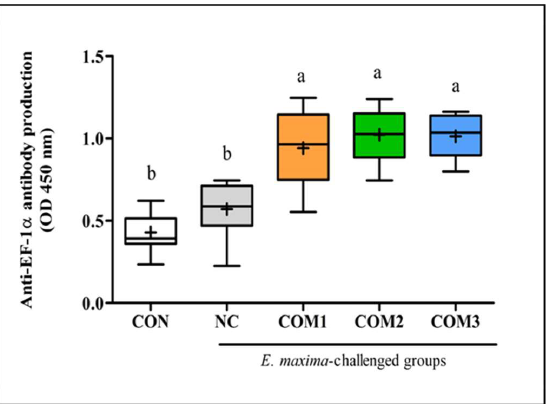
Figure 2. Synergetic effect of recombinant EF-1α and B. subtilis expressing cNK-2 peptide on anti- EF-1α antibody titer post- E. maxima infection. a–b different letters between group denote significant differences ( p < 0.05) according to the Tukey’s multiple range test ( n = 30). Abbreviations: CON, non- immunized and non-infected control; NC, non-immunized and infected control; COM, component; nd, not detected.